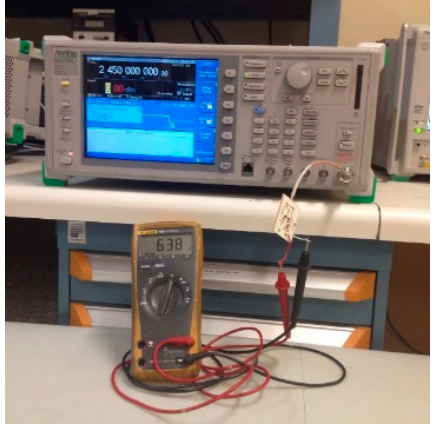
Figure 16. Experimental setup.